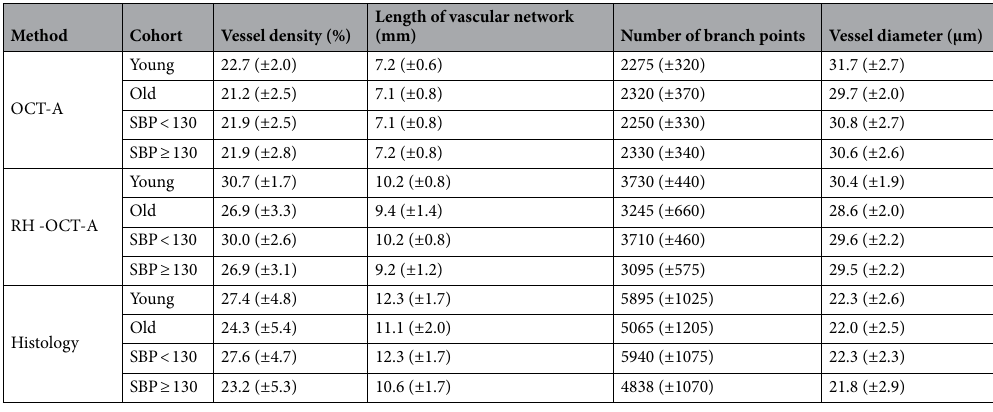
Table 1. Impact of age and systolic blood pressure (SBP) on the vasculature assessed by optical coherence tomography angiography (OCT-A), reactive hyperemia optical coherence tomography angiography (RH-OCT-A), and